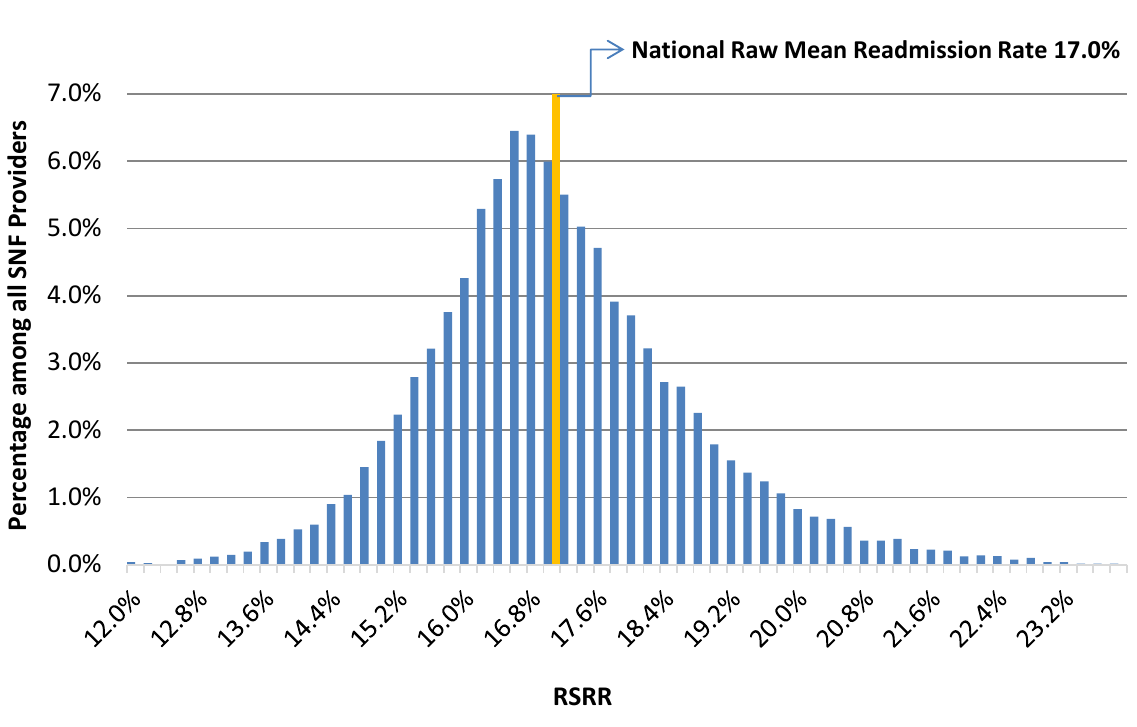
Figure 12.1: Distribution of Risk-Standardized Readmission Rate (RSRR) Measure